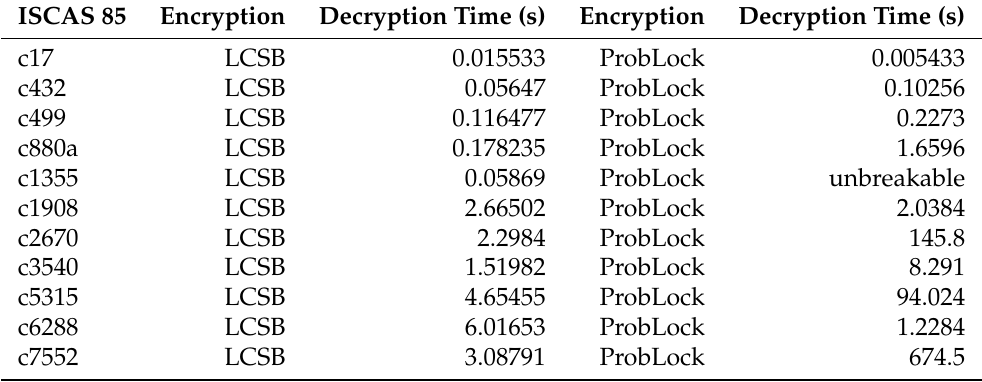
Table 6. ISCAS ’85 SAT Attack